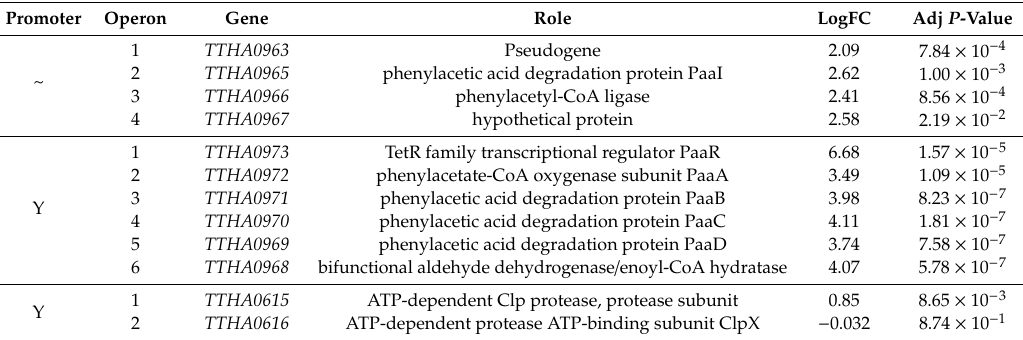
Table 5. TTHA0973-promoter binding